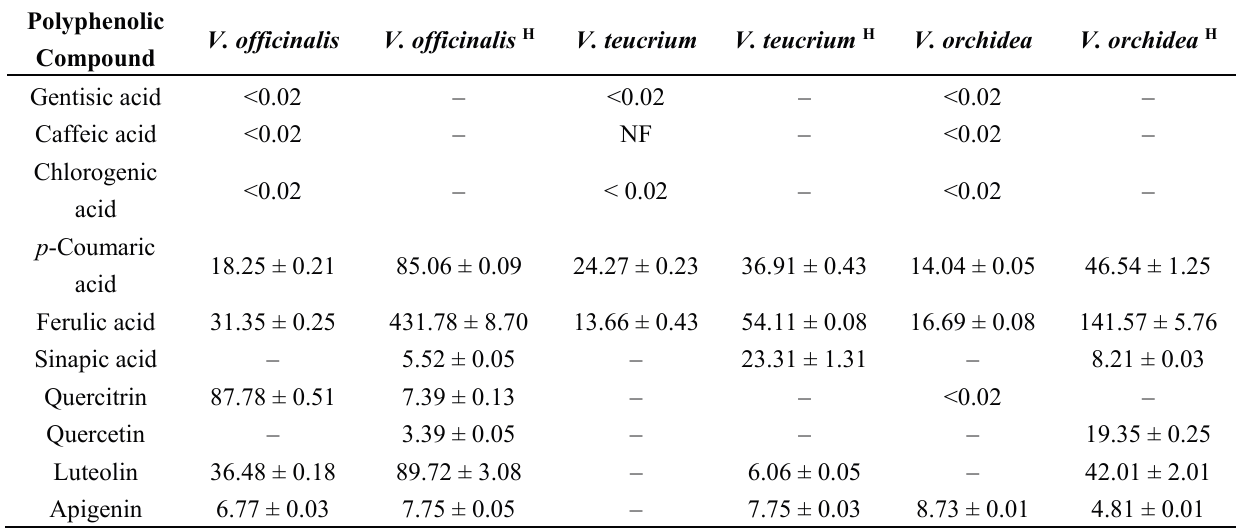
Table 1. The polyphenolic compounds content in the studied samples ( μ g/g d.w. plant material).